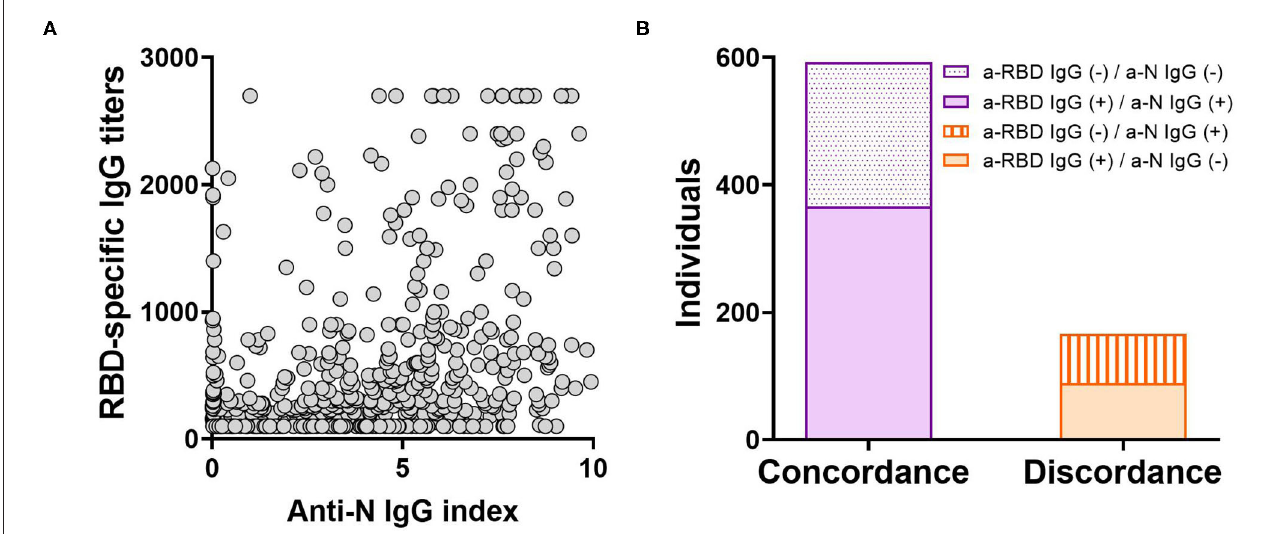
FIGURE 2 | Comparison between the “ In-House ” ELISA and others tests in correctly discriminating previous infection by SARS-CoV-2. (A) Scatterplot depicting the relationship between titers from the anti-RBD “ In-House ” ELISA and the anti-N CMIA index for 758 individuals ( r = 0.5048; p < 0.0001). The correlation was analyzed using Pearson Correlation Coefficient. (B) Concordance or discordance in results from the anti-RBD ELISA and the anti-N CMIA assay in the screening of IgG antibodies elicited after SARS-CoV-2 infection.